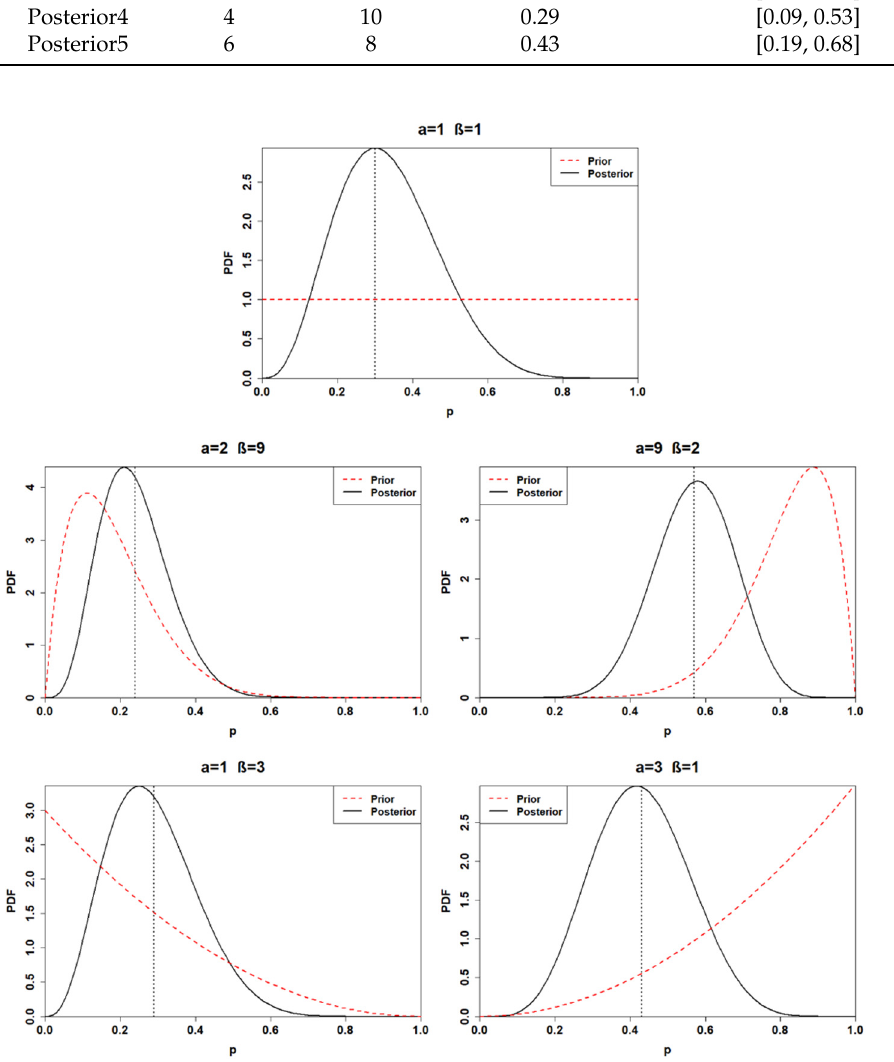
Figure 1. Posterior distributions of the first application (sample with n = 10, k = 3) for distinct choices of prior. The black dashed lines represent the posterior mean values.